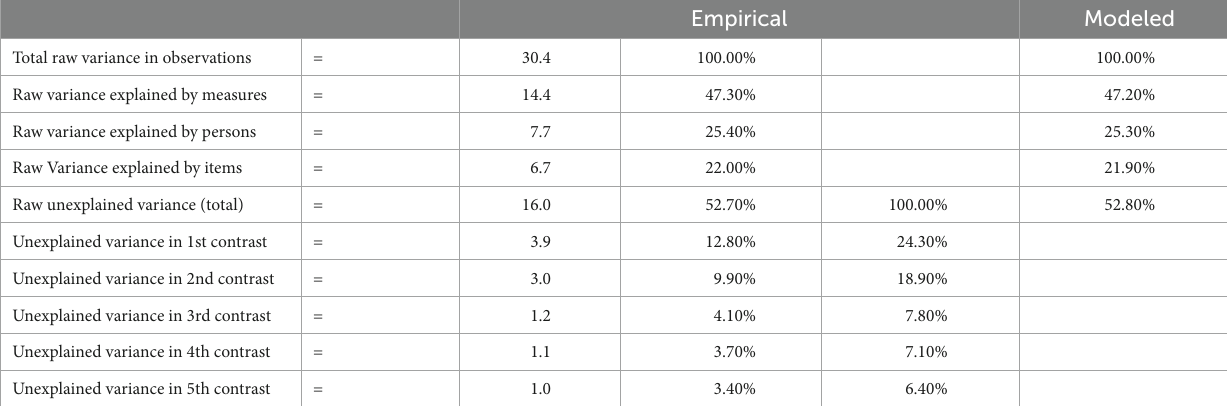
TABLE 2 Standardized residual variance (in eigenvalue